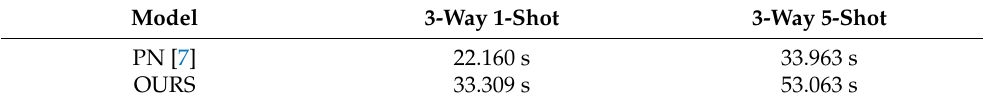
Table 5. The time usage of the methods to preprocess 1 epoch in the training stage. Model